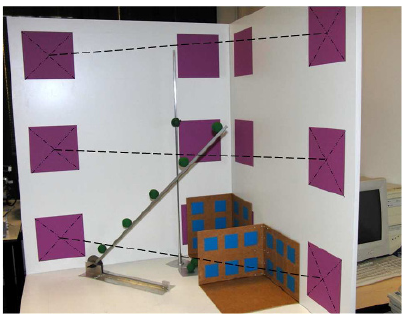
Figure 6. Reconstruction of 3D space in double-plane method is based on four plane-to-plane projections.